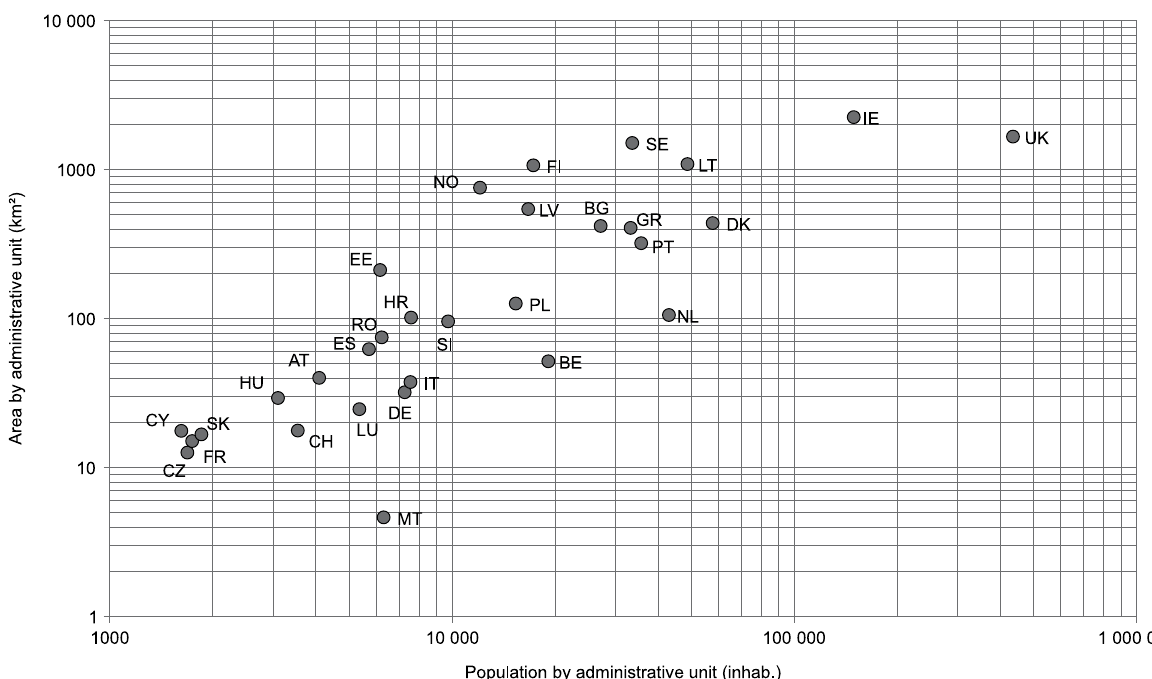
Fig. 1. Distribution of European countries by indicators of the average population and area (logarithm